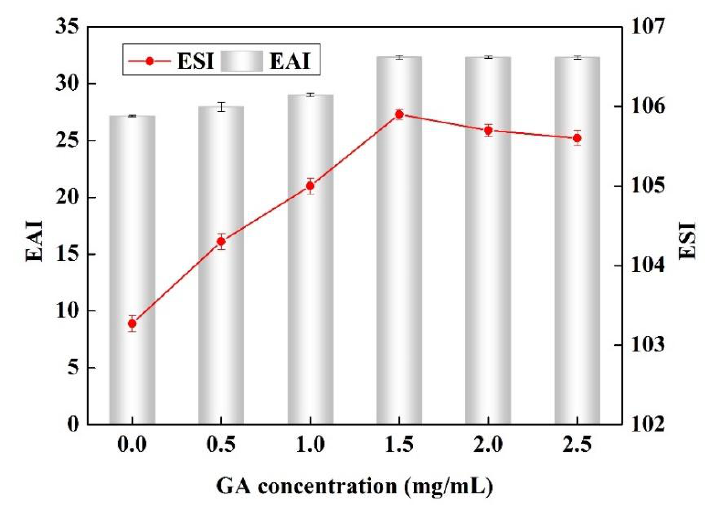
Figure 6. EAI and ESI of Pv–GA complexes prepared with different concentration of GA.